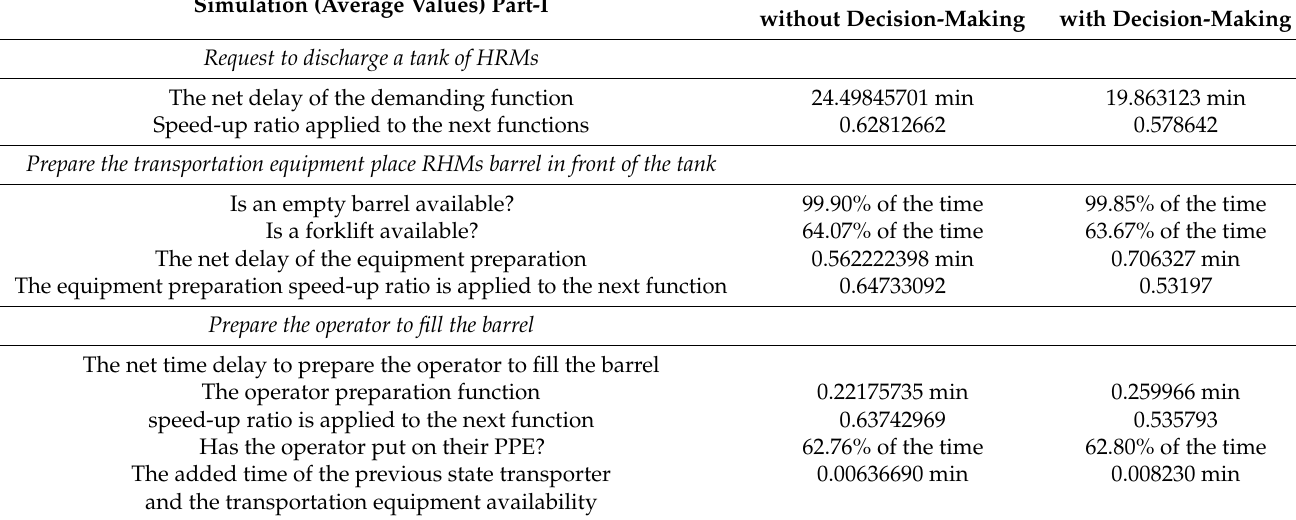
Table 2. The simulation summary results for the first and the second parts of the